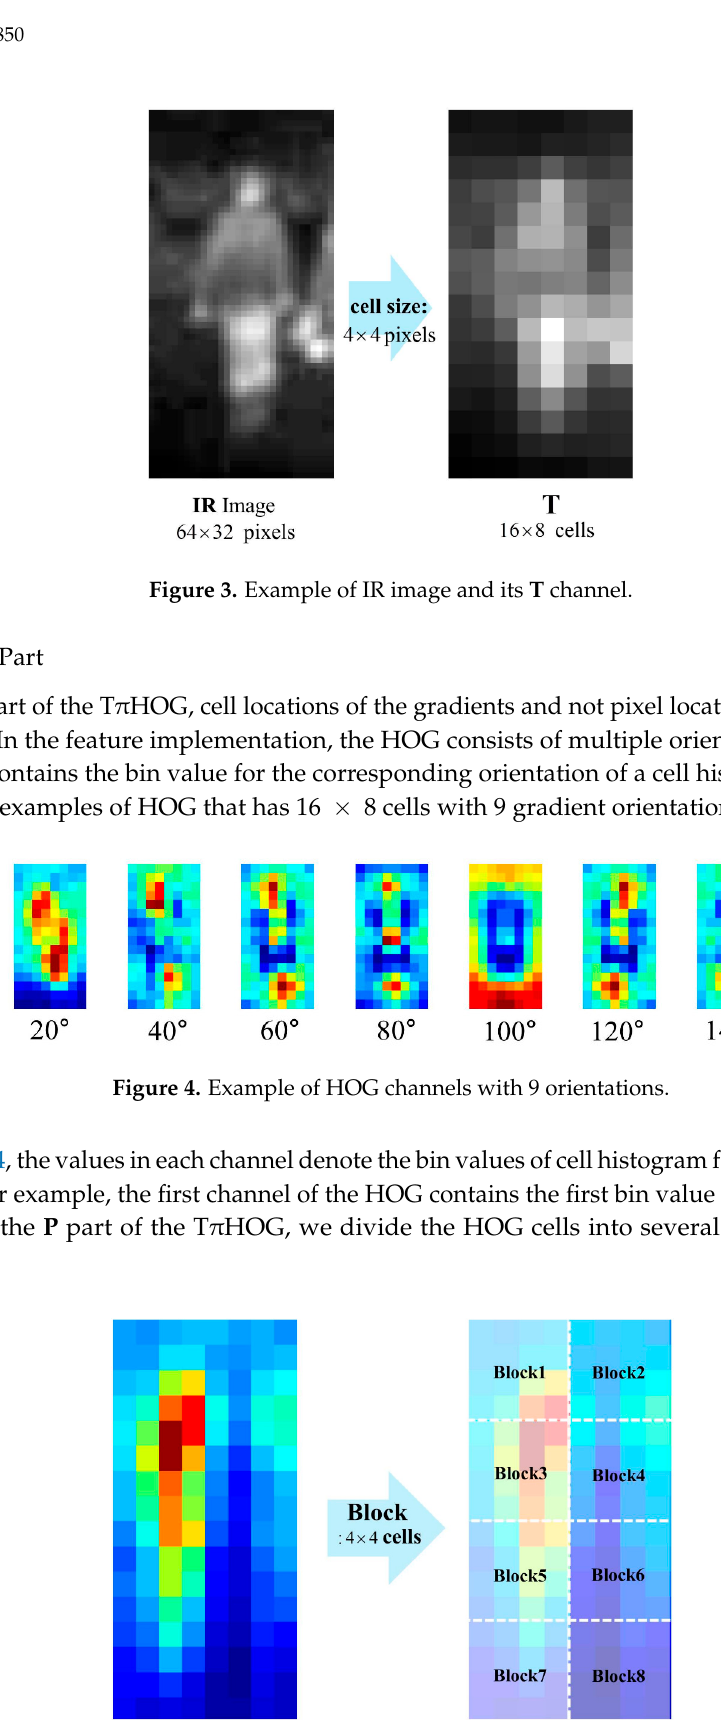
Figure 5. Example of dividing HOG into 8 blocks.